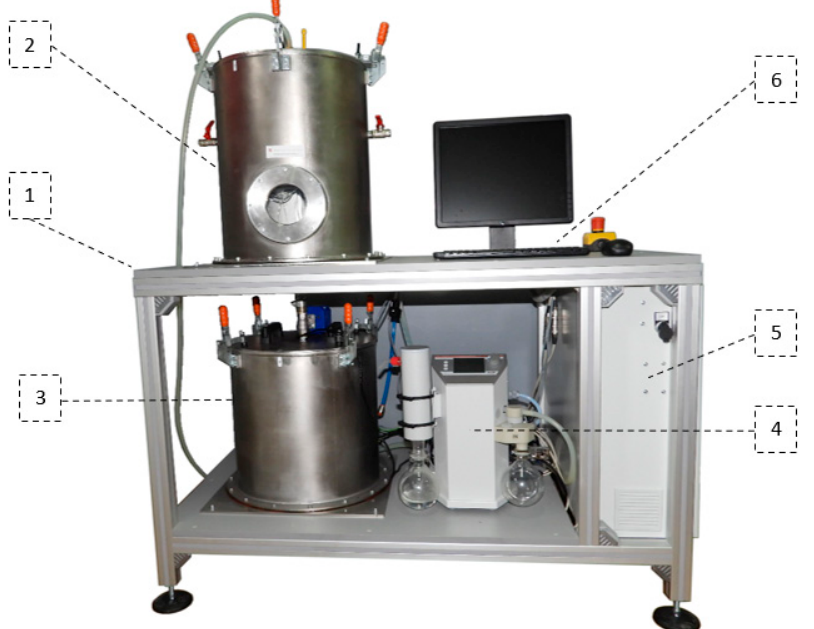
Figure 2. The intensified heat transfer adsorption bed (IHTAB) facility: 1—aluminum frame, 2— reaction chamber, 3—evaporator chamber, 4—vacuum pump, 5—data acquisition and control system, 6—computer.